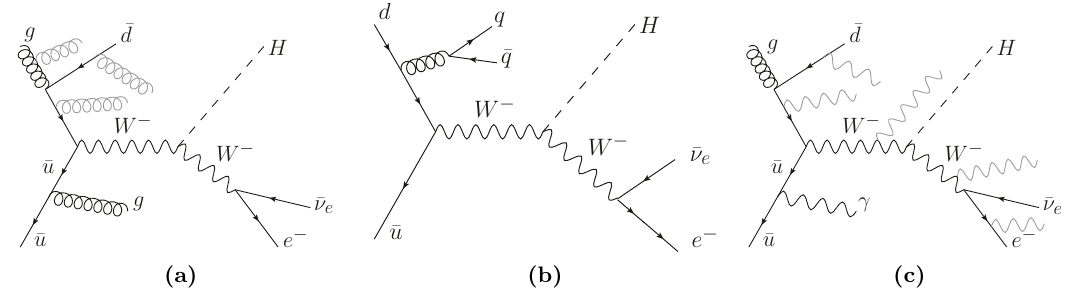
Figure 1. A sample of QCD (a, b), and EW (c), real radiation diagrams contributing to HW (cid:0) j production. While only one photon or gluon at a time is present at (cid:12)xed order, for illustration purpose, in (a) and (c), we have shown various possible gluon and photon emissions.